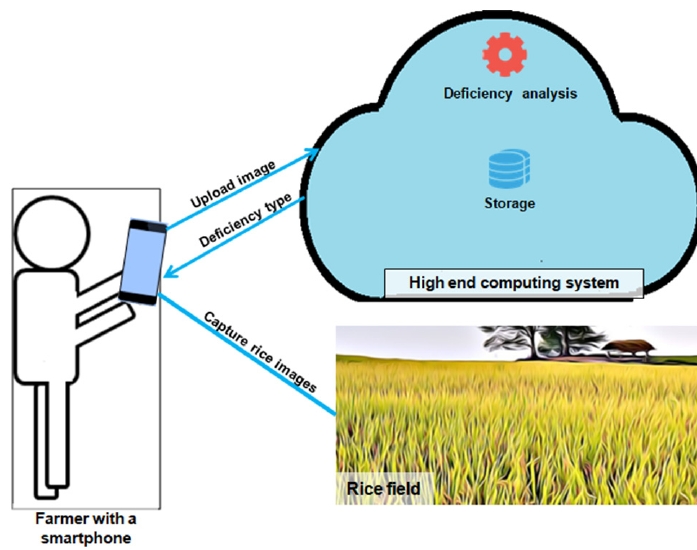
Figure 2. Cloud-based nutrient deficiency diagnosis framework in